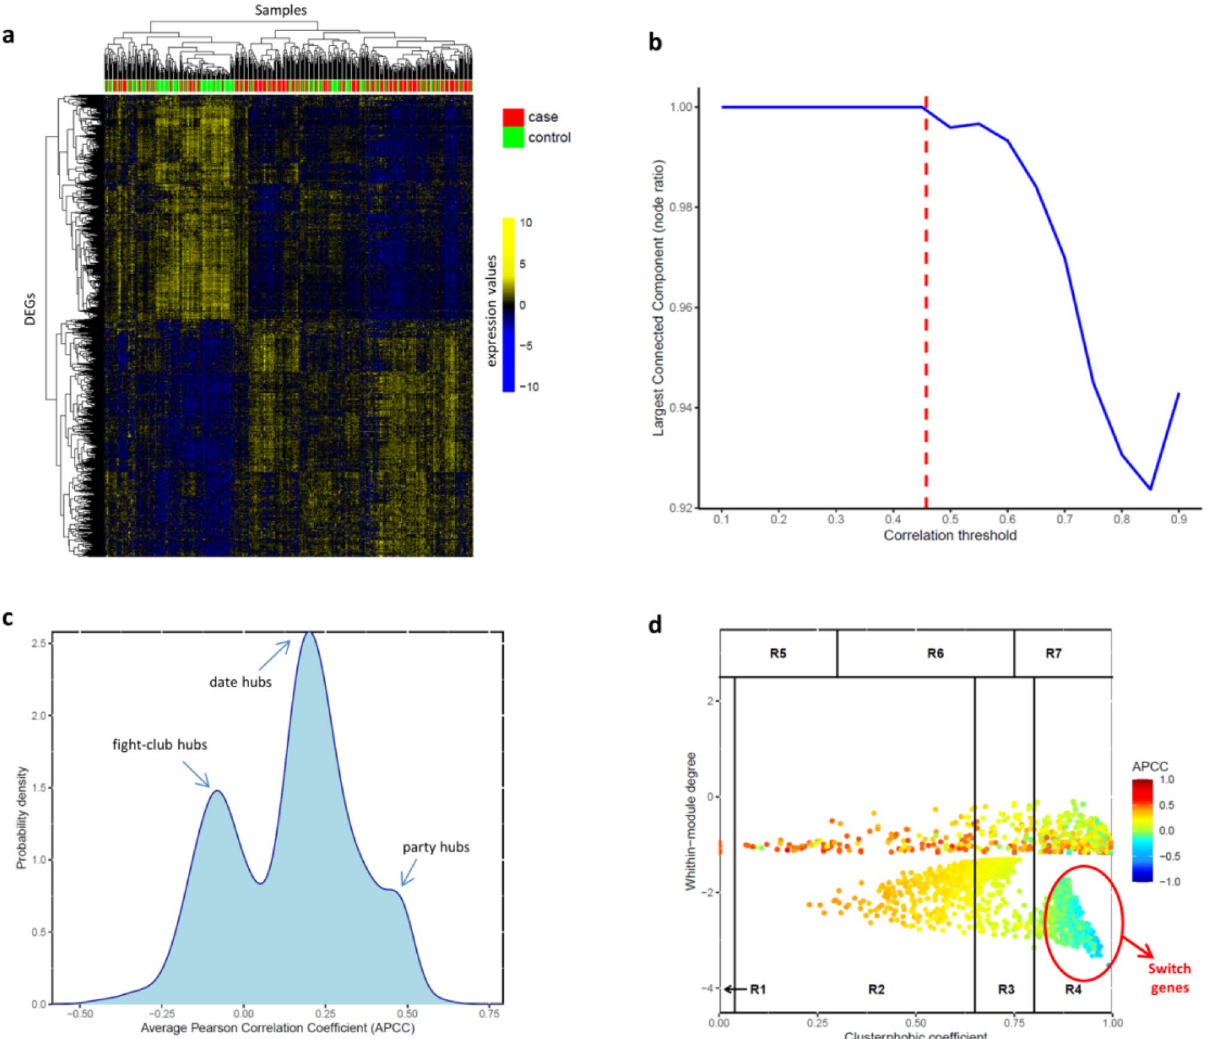
Figure 4. SWIMmeR results on AD gene expression data. ( a ) Differentially expressed genes (DEGs). Differentially expressed profiles are clustered according to genes (rows) and samples (columns) by using Pearson correlation distance as metrics. Heat map colours represent different expression levels increasing from blue to yellow. AD samples (case) are indicated in red, whereas control samples are indicated in green. ( b ) Connectivity of correlation network. The x-axis represents the Pearson correlation threshold varying in the chosen range, while the y-axis represents the fraction of nodes populating the largest component. The dashed red line corresponds to the selected threshold (i.e., 0.46 or 83th percentile). Note that y = 1 means that all nodes fall in the largest component and thus the network is fully connected; otherwise more components exist. ( c ) APCC distribution. Probability distribution of APCC for hubs (i.e., node with degree greater than 5) identified in the AD correlation network. Note the presence of the three peaks associated to the date/party/fight-club hub classification. ( d ) Heat cartography map. Dots correspond to nodes in the AD correlation network. Each node is coloured according to the value of the APCC between its expression profile and that of its nearest neighbours in the